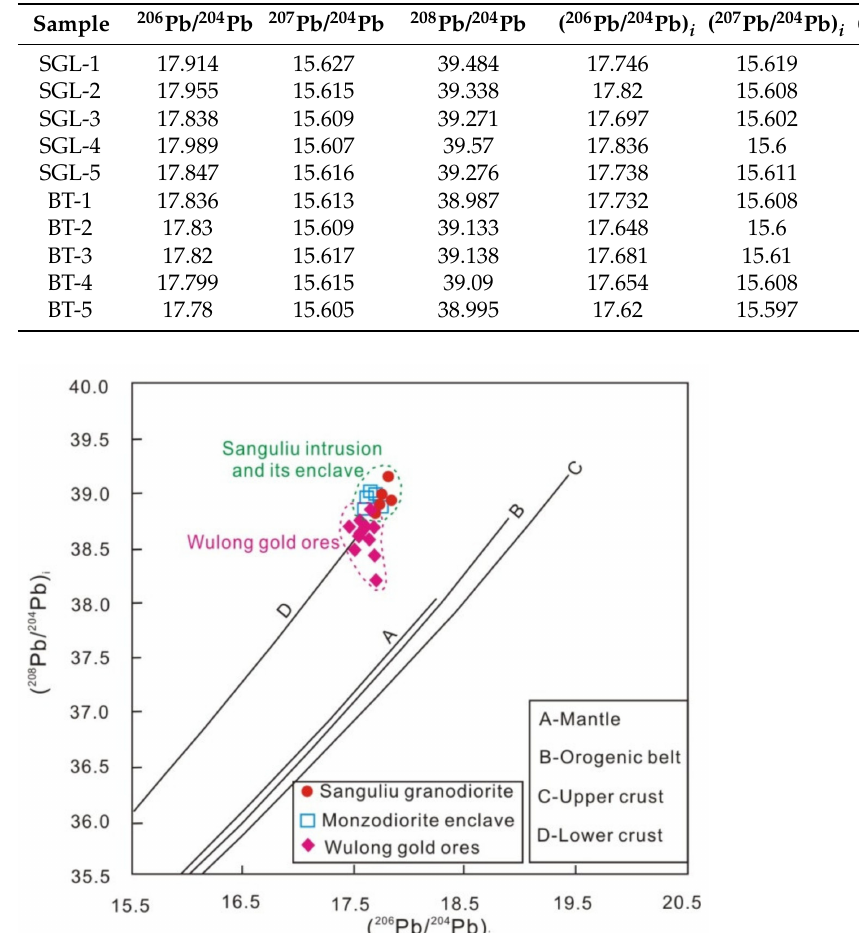
Table 6. Pb isotopic data for the host Sanguliu granodiorite and monzodiorite enclaves.